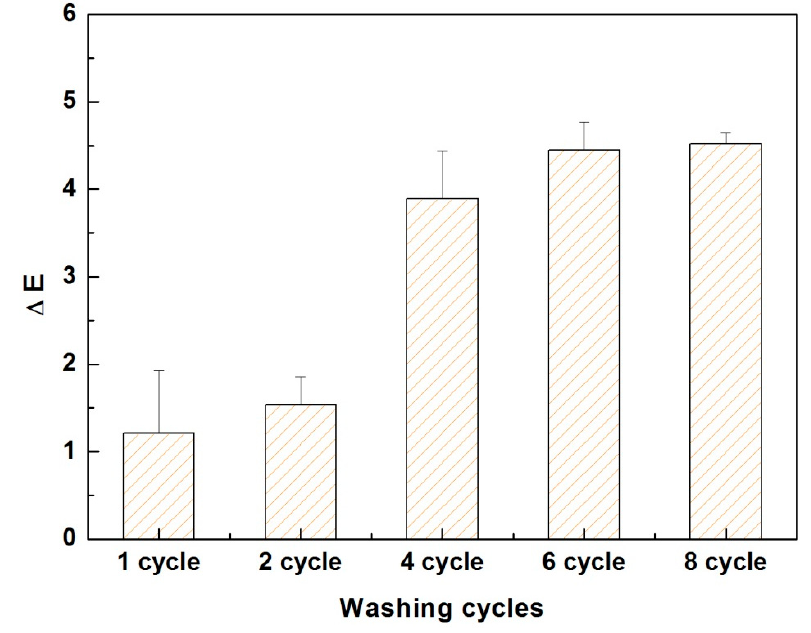
Figure 10. Evolution of the color difference ( ∆ E ) of methylene blue dyed (PDADMAC/PAA) 2.5 -PET fabric with increasing the number of washing cycles.